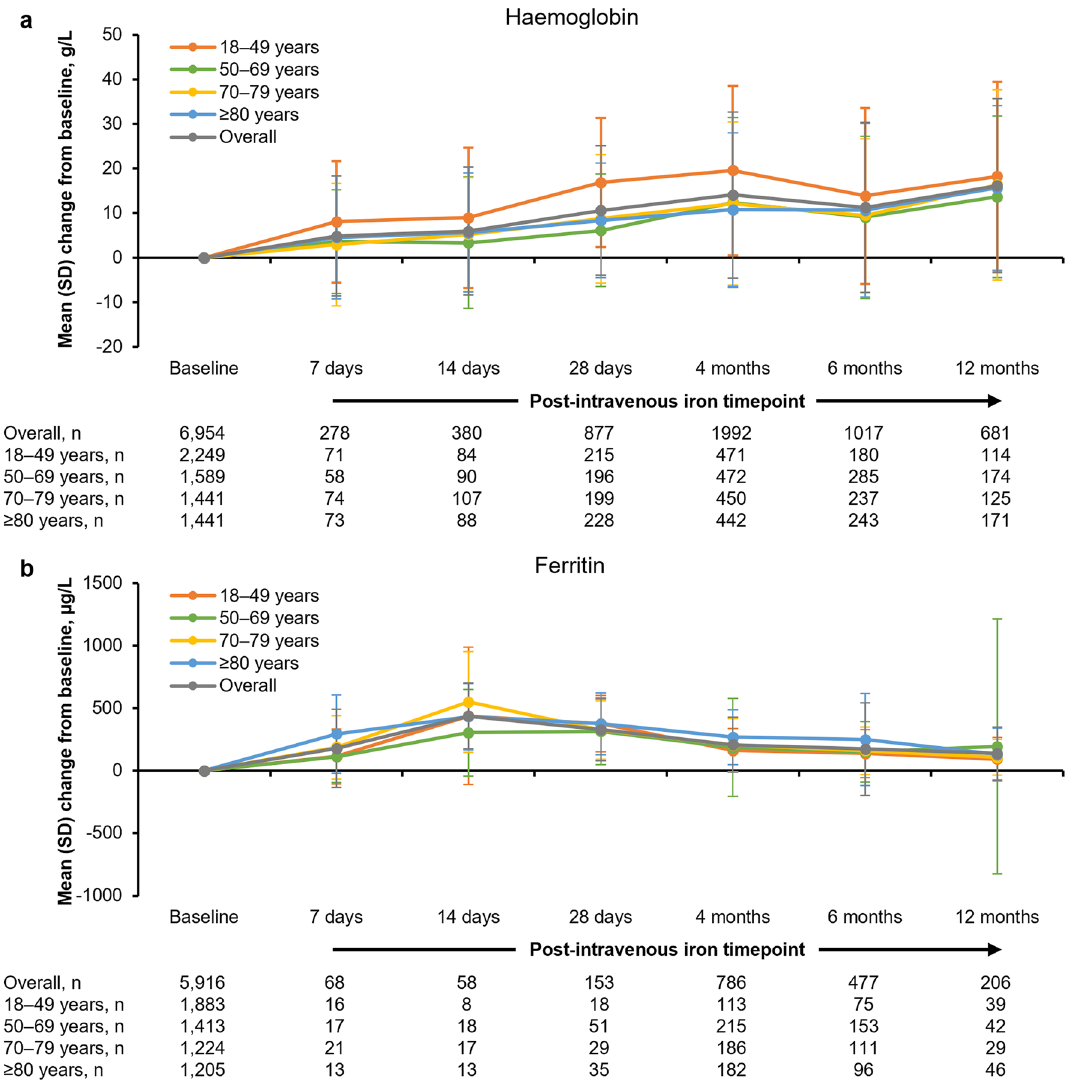
Figure 2. Change from baseline in haemoglobin and ferritin following first course of FDI, by patient age. Baseline mean (SD) data for all intravenous iron patients: haemoglobin = 99.6 (17.56) g/L; ferritin = 62.8 (149.64) μg/L. For all age groups, the increase in haemoglobin and ferritin versus baseline was statistically significant at 4 months (p < 0.0001). SD standard